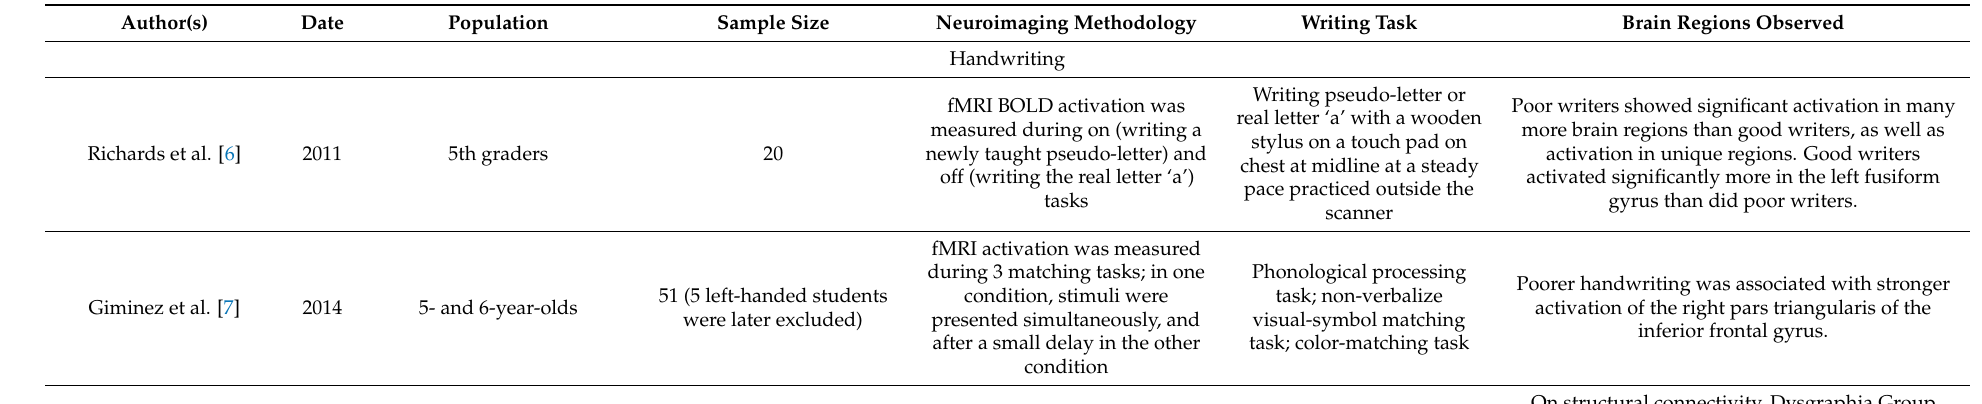
Table 1. A summary of neuroimaging studies examining brain structures and functions during various writing tasks in